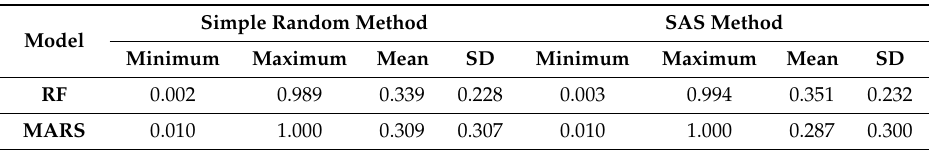
Table 7. Statistical characteristics of the probability values obtained from the random forest (RF) and multivariate adaptive regression splines (MARS) models based on the simple random and selection of absence samples (SAS)